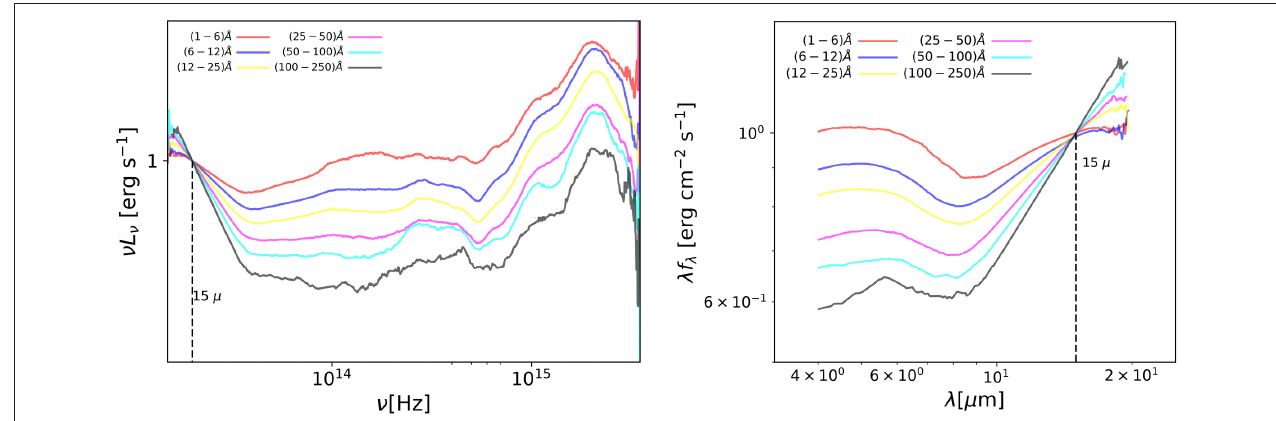
FIGURE 3 | Left: Spectral Energy Distributions for the six EW[OIII] bins, corresponding to different inclination angle ranges. The master SED for a EW[OIII] bin was realized as follows: the photometric data for each source from the GALEX , SDSS, 2MASS and WISE surveys were corrected for Galactic reddening, rest-framed, interpolated on a common grid and normalized to the ν L ν value corresponding to the reference wavelength (15 µ m); for every channel in the grid we then selected the median value. Right: Total flux for the six EW[OIII] bins in the spectral range in which the emission coming from the torus is predominant. SED corresponding to low EW[OIII] values are characterized by a shallower decrease in the emission at the shorter IR wavelengths with respect to the longer ones, while in the case of high EW[OIII] the decrease is steeper. This behavior is in agreement with the clumpy torus models (see text for details).